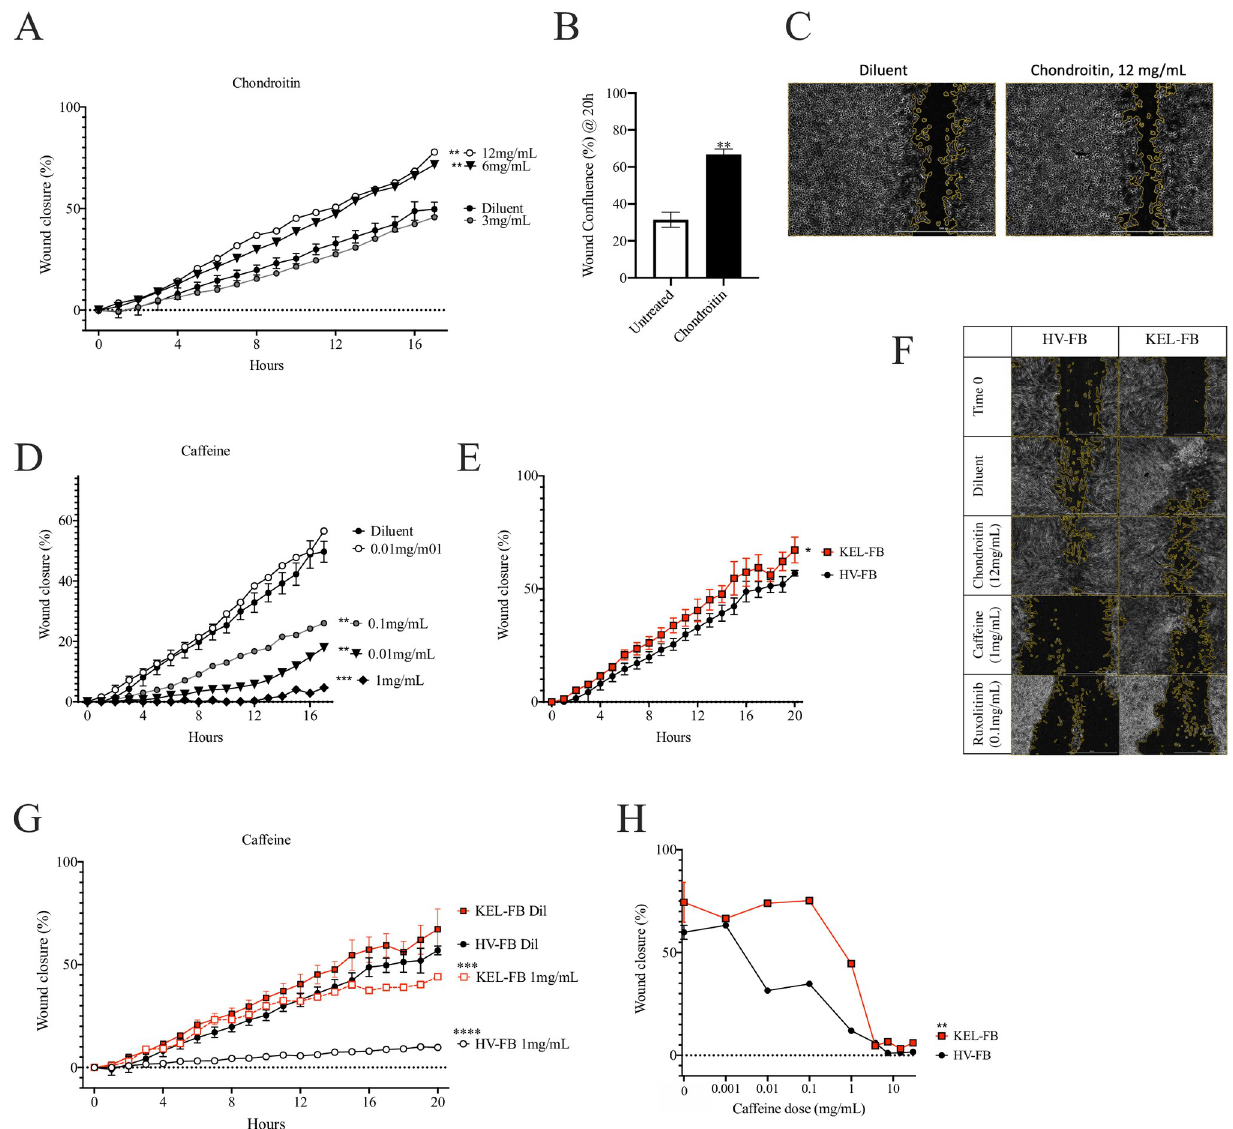
Fig 2. Caffeine, but not chondroitin, inhibit scratch repair in keloid and healthy volunteer fibroblasts. (A) Wound closure over 18 hours for healthy volunteer fibroblast line (HV-FB) treated with indicated concentrations of chondroitin. (B-C) Wound closure (B) and representative image (C) for HaCaT keratinocytes at 20hours with treatment of 12mg/mL of chondroitin at 18 hours. (D) Wound closure over 18 hours for HV-FB treated with indicated concentrations of caffeine. (E-F) Wound closure over 22 hours and representative images at 22 hours (F) for HV-FB or a commercially available fibroblasts cell line from a patient with keloid scaring (KEL-FB). (G) Wound closure over 22 hours for HV-FB and KEL-FB treated with 1mg/mL caffeine. (H) Wound closure at 14 hours for HV-FB and KEL-FB treated with indicated concentrations of caffeine. Results are representative of three independent experiments and displayed as mean + SEM for triplicate wells. � = p < 0.05; �� = p < 0.01; ��� = p < 0.001; for statistical comparison of area under the curve versus HV-FB under diluent stimulation conditions as determined by ANOVA with Sidak adjustment. Masking on representative images of scratch assay performed by Scratch App